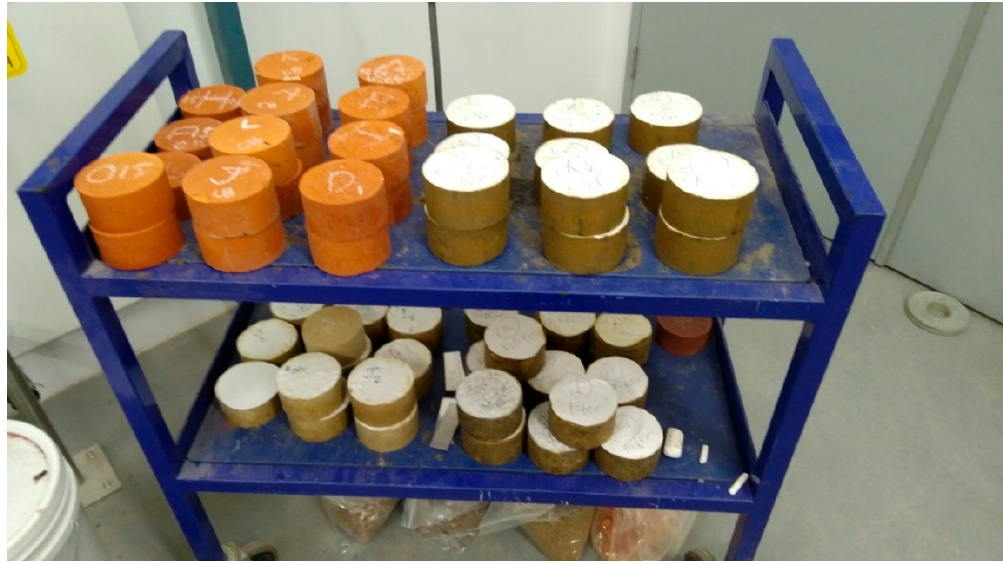
Figure 1. Bricks before and after firing.